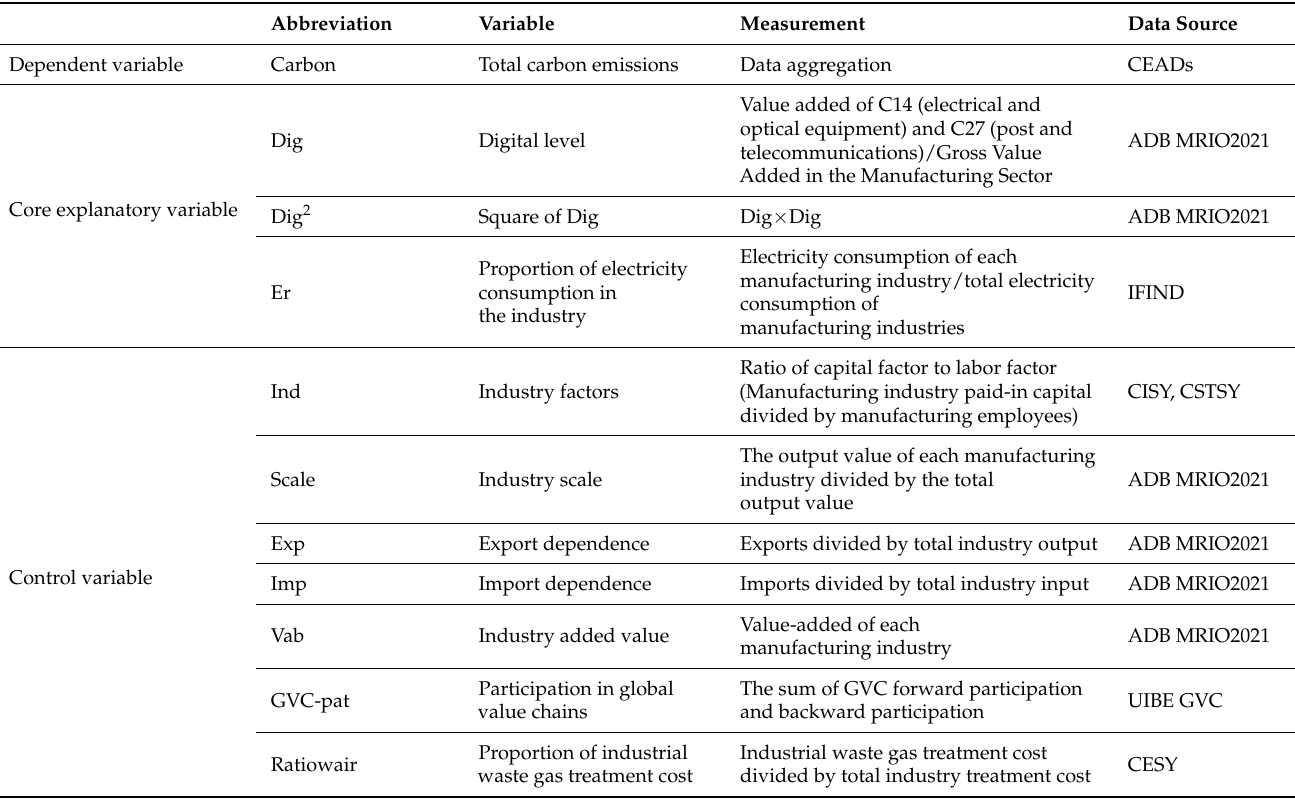
Table 1. Variables and data